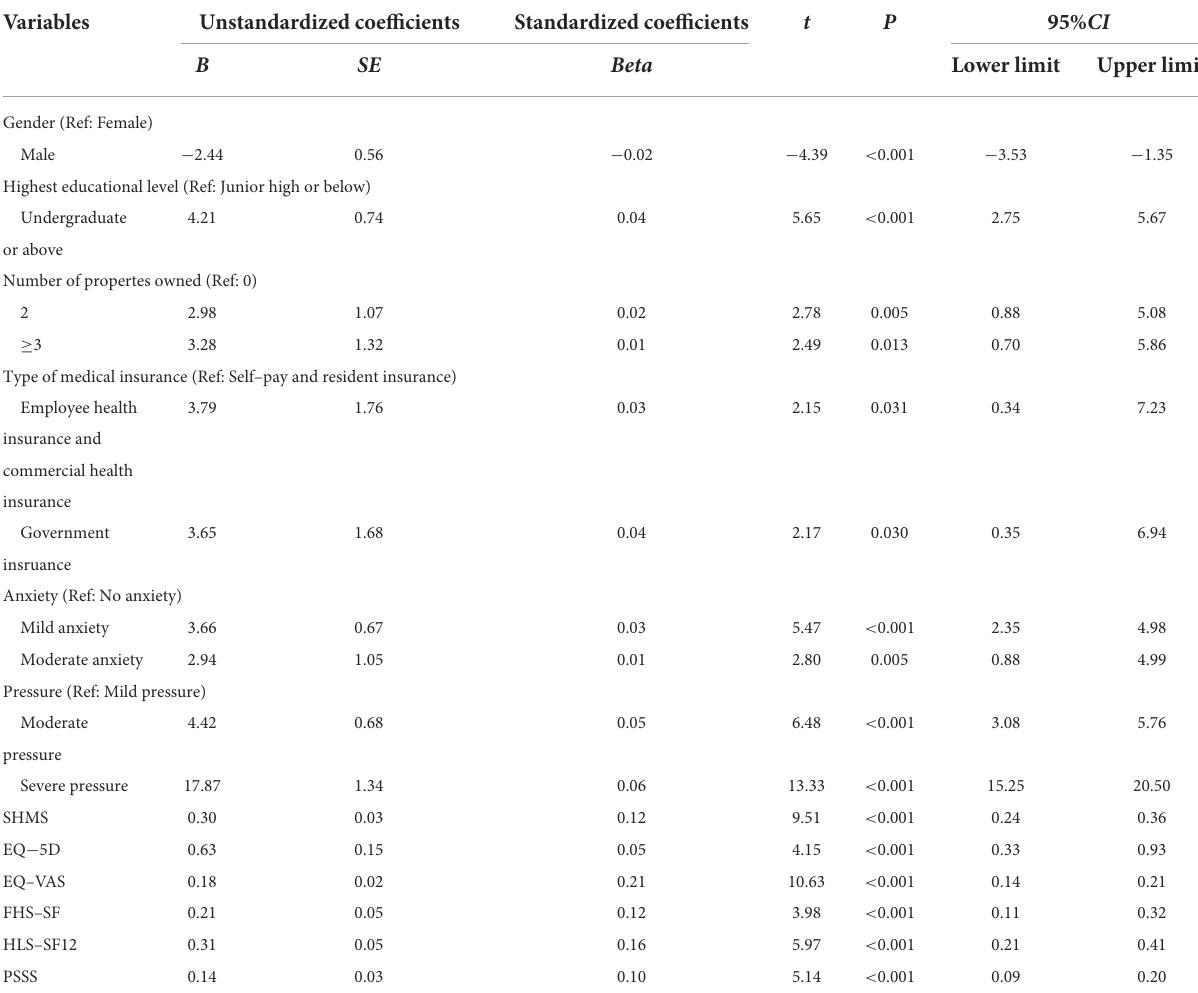
TABLE 2 Stepwise regression analysis of factors related to acceptance of hospice care. Variables Unstandardized coefficients Standardized